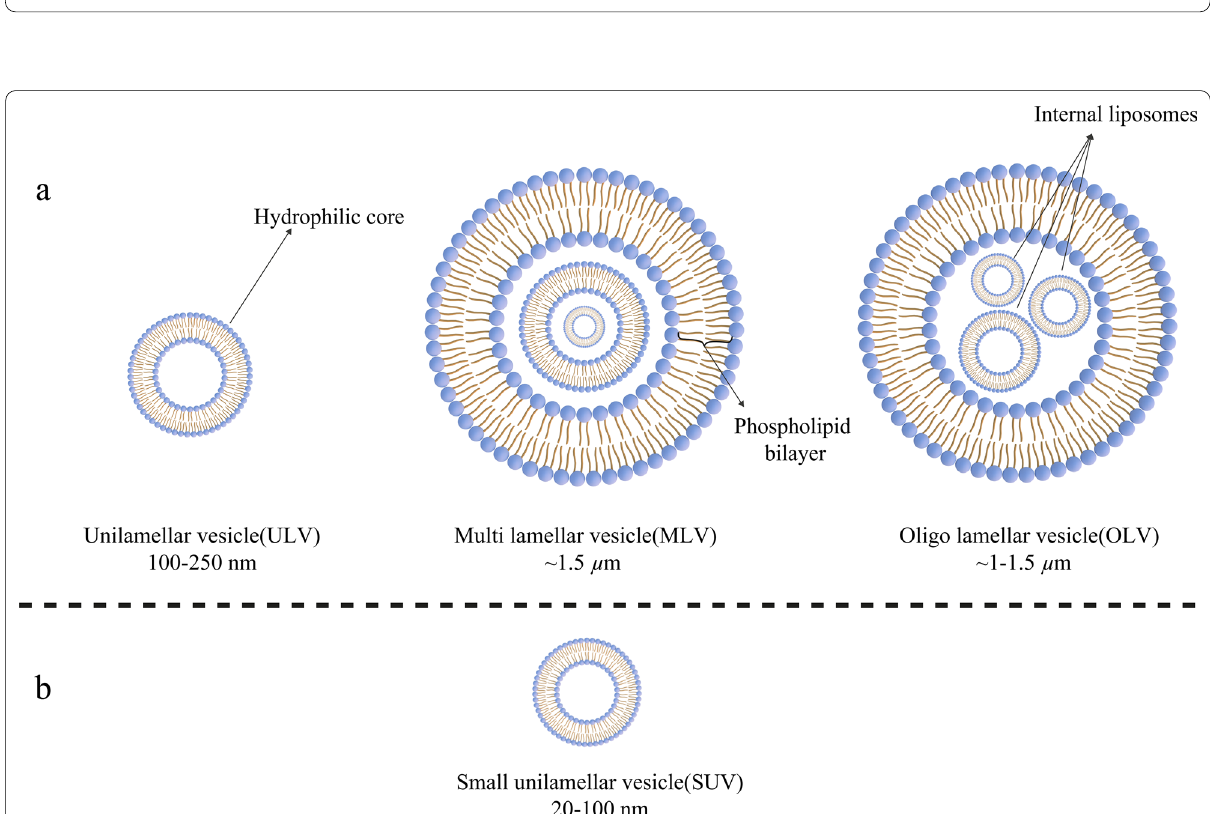
Fig. 2 Schematic figure of liposomes originated from lecithin. Different regions of liposomes, including hydrophilic core and hydrophobic bilayer, are demonstrated. The structure of the lecithin molecule, its hydrophilic pole, and hydrophobic chains are specified